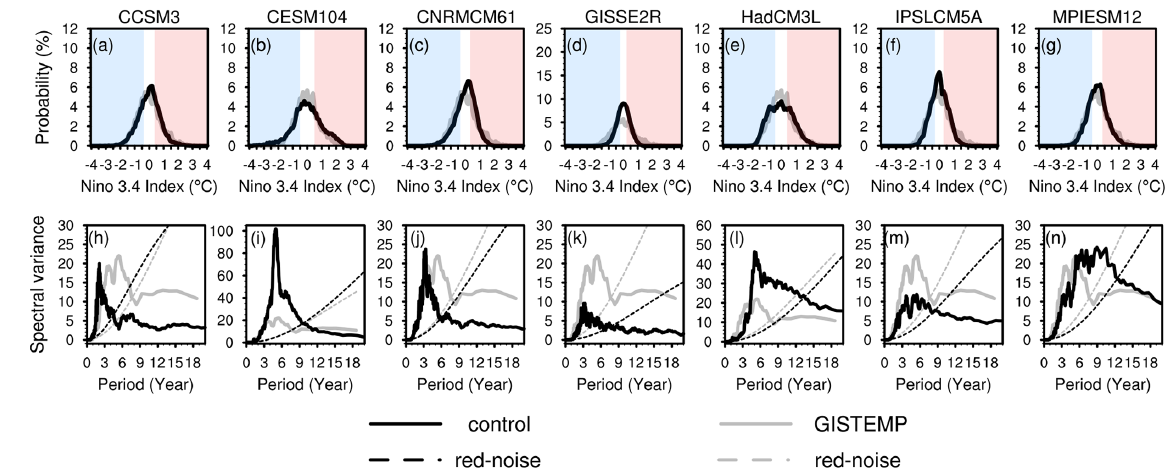
Figure 2. (a–g) Histograms and (h–n) power spectra of the Niño3.4 index in the observations and the control. The blue and red shades in the upper panels represent La Niña and El Niño events, respectively. The dashed lines in the bottom panels represent the 0.95 confidence bound of the Markov red noise spectrum in the observations (gray) and the control (black).